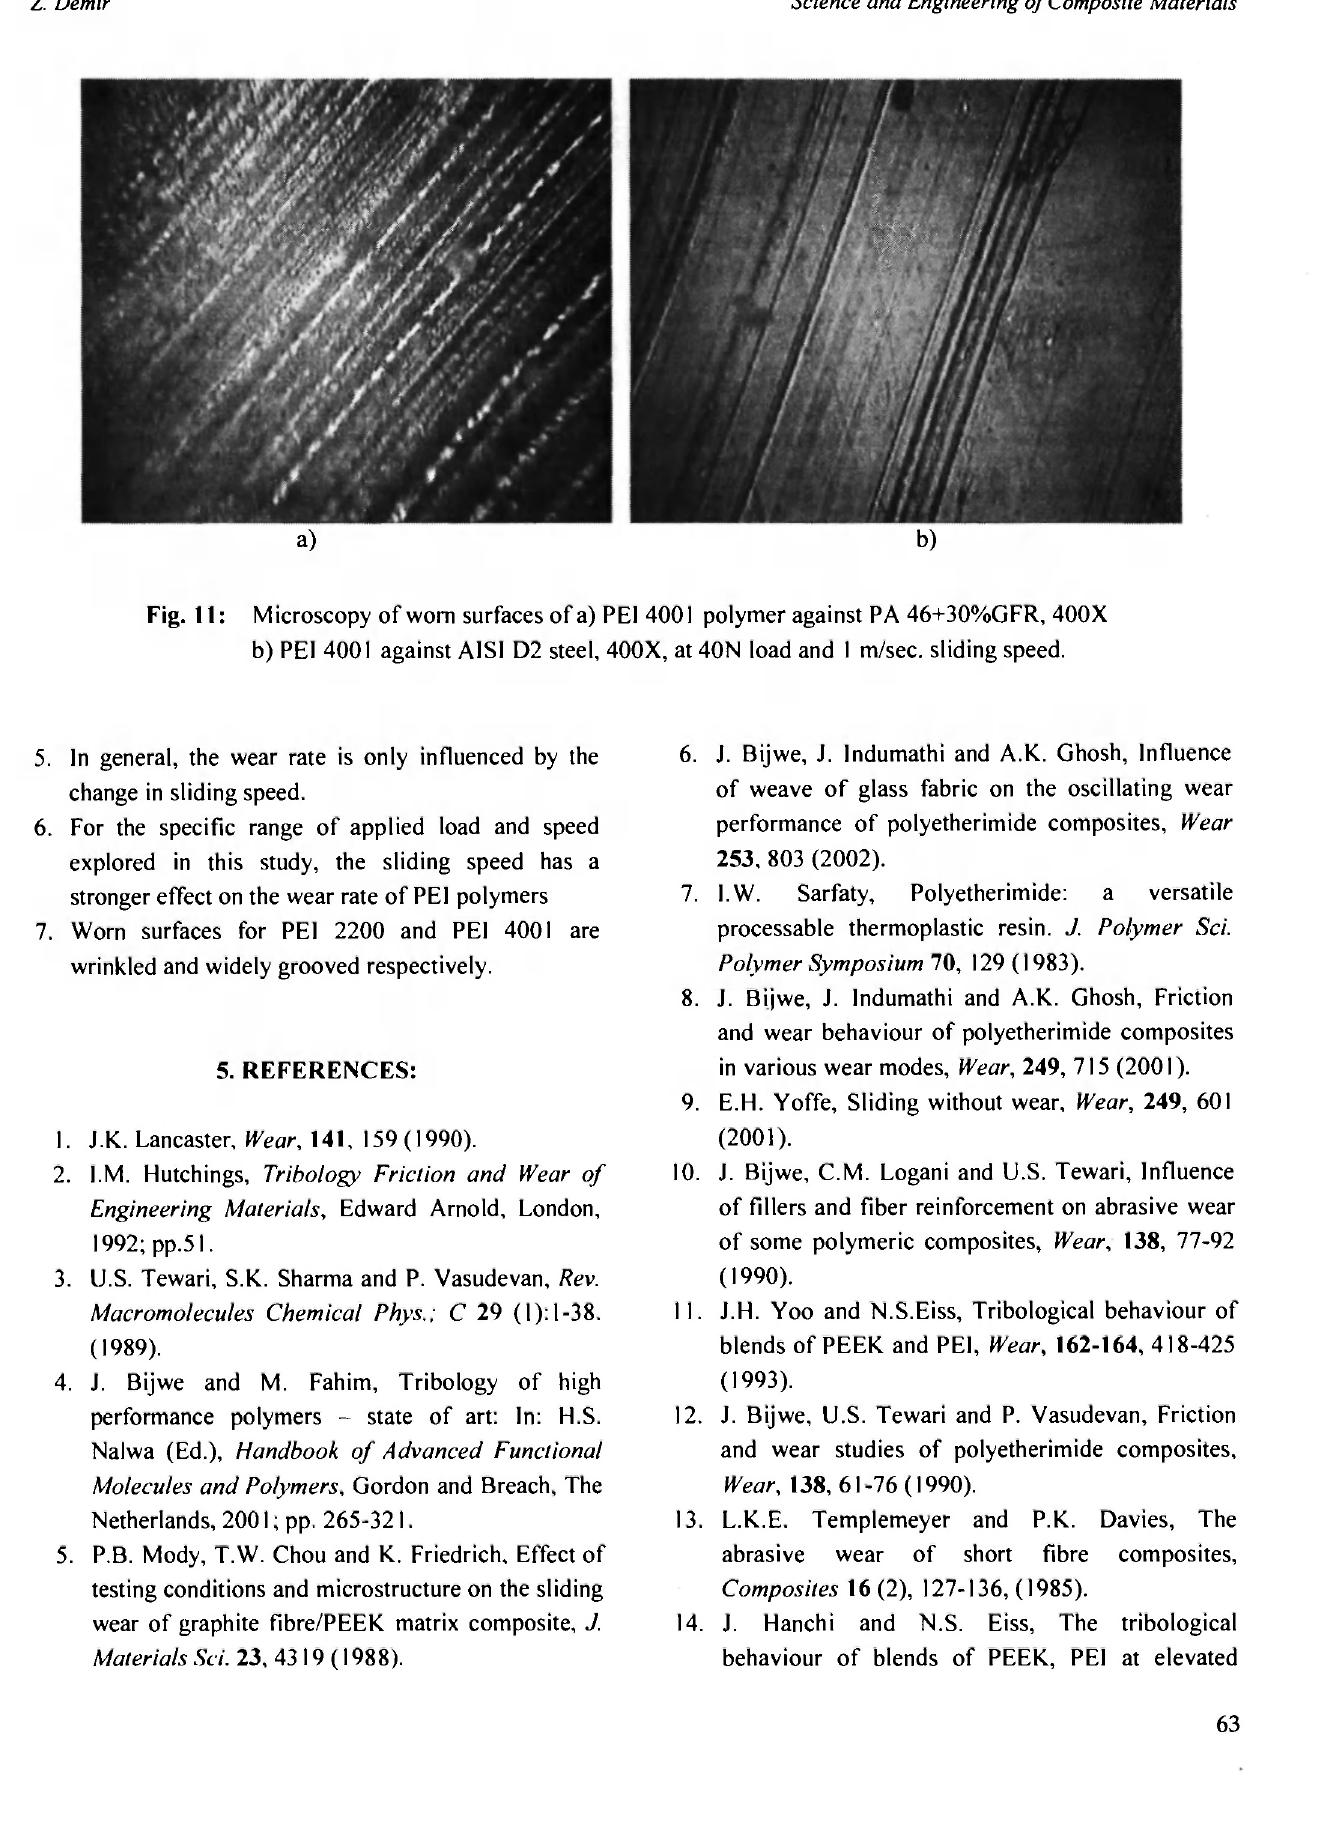
Fig. 11 : Microscopy of worn surfaces of a) PEI 400 1 polymer against PA 46+30%GFR, 400X b) PEI 4001 against AISI D2 steel, 400X, at 40N load and 1 m/sec. sliding